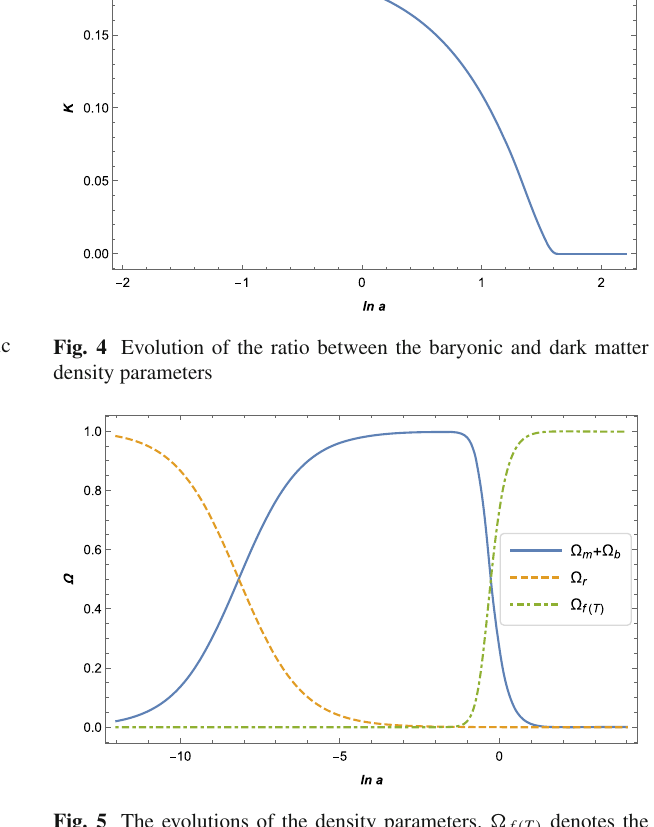
Fig. 3 Evolutions of density parameters (cid:9) b and (cid:9) m